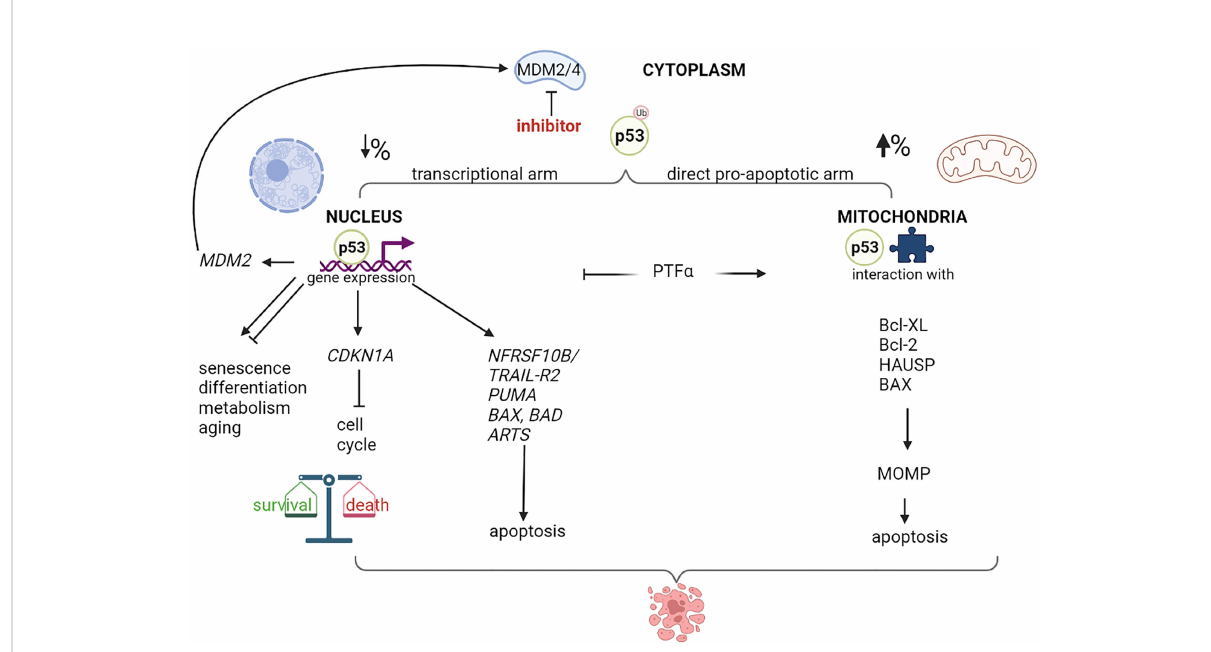
FIGURE 1 Nuclear and mitochondrial p53 destination after MDM2/4 inhibition. Schematic representation of different destination of p53 after treatment with a MDM2/4 inhibitor. Cytoplasmatic monoubiquitinated p53 can move through nucleus or mitochondria and activate programs of gene expression or direct apoptosis induction, with different percentage depending on cellular context. p53-mediated expression modulates live and death pathways, resulting typically in cell cycle block and apoptosis after MDM2 inhibition. A negative-feedback control is represented by the MDM2 p53-dependent expression. Treatment with a speci fi c inhibitor of p53-mediated transcription, such as Pi fi thrin-alpha (PTF a ), orients the program to mitochondria, resulting in mitochondrial damage, membrane permeability (MOMP) and higher apoptotic levels. Created with